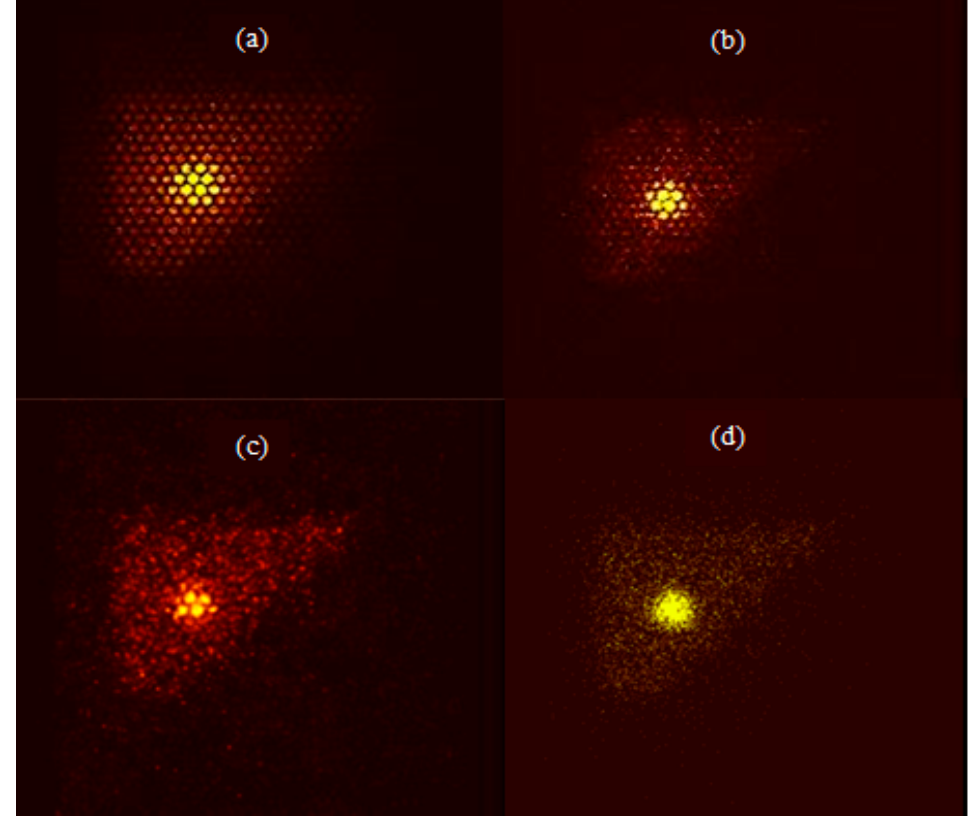
Figure 10. Planar image acquired from GATE MC simulation for 159 Gd and 99m Tc utilizing VV image viewer: ( a ) 159 Gd (58 + 363.54 keV), ( b ) 159 Gd (58 keV), ( c ) 159 Gd (363.54 keV), and ( d ) 99m Tc (140 keV).